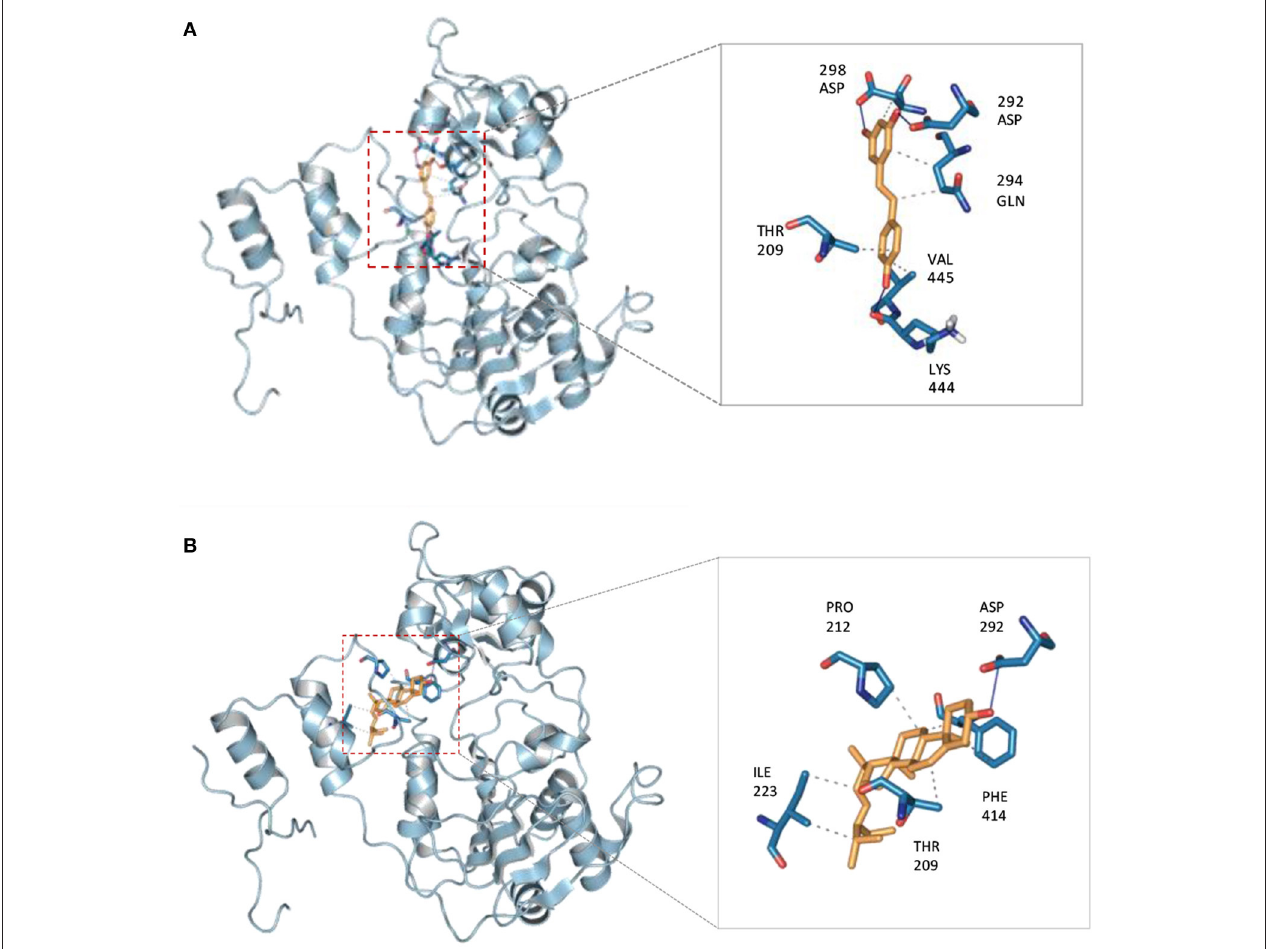
FIGURE 6 | 3D views of binding interaction of SIRT1 with (A) resveratrol compared with (B) stigmasterol.